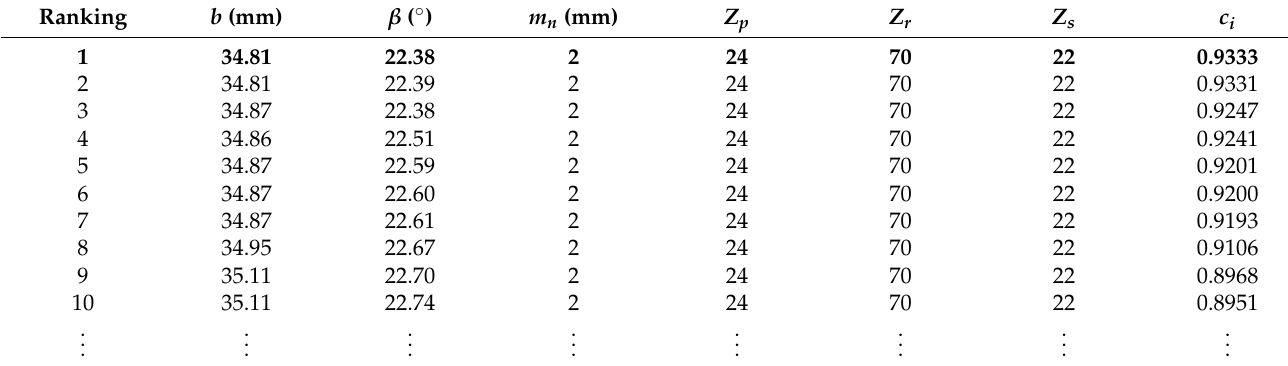
Table A2. Optimization results from MUOD (Case 1).